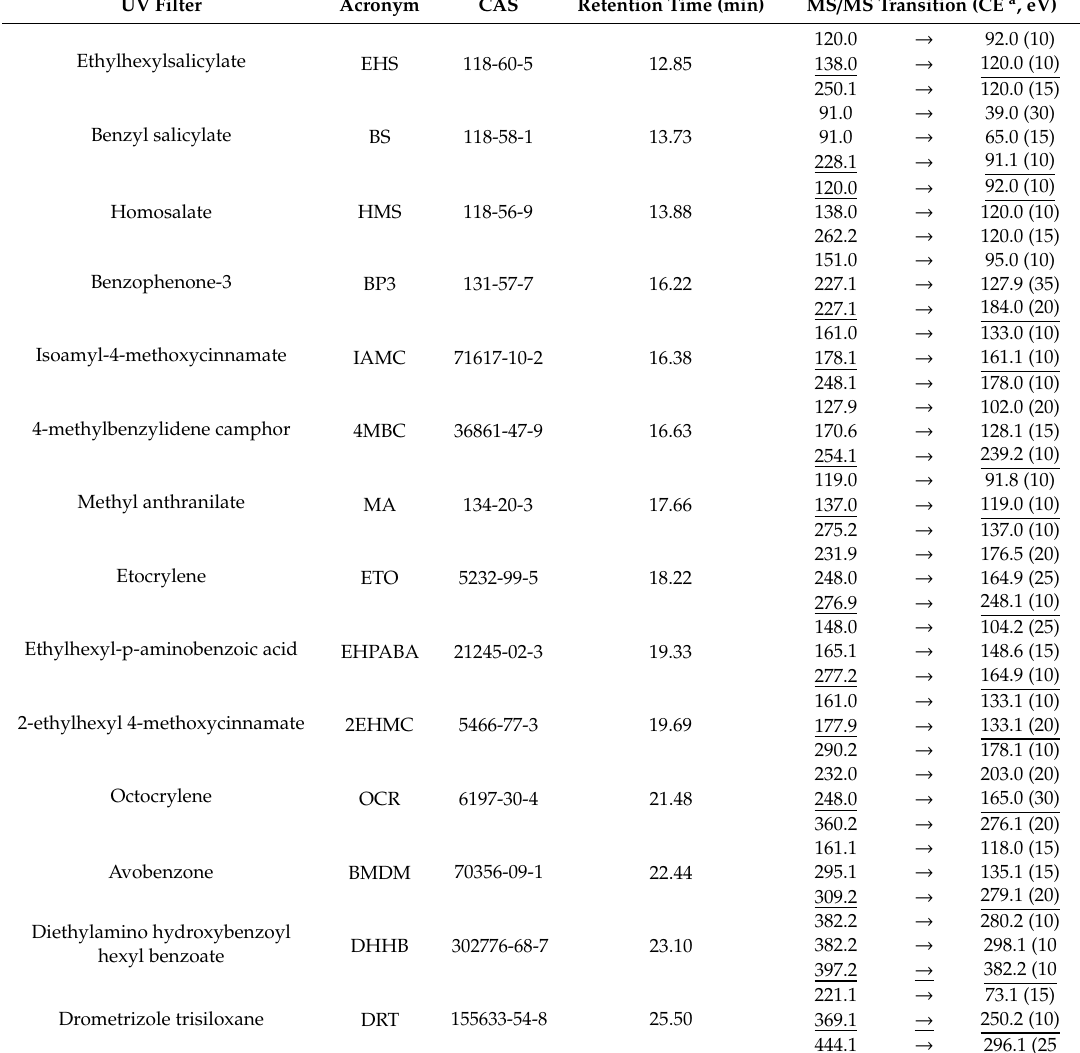
Table 1. Studied ultraviolet (UV) filters. CAS number, retention time and mass spectrometry (MS) / MS